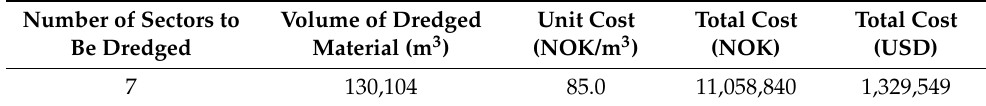
Table 2. Number of sectors to dredge, total volume, and cost.